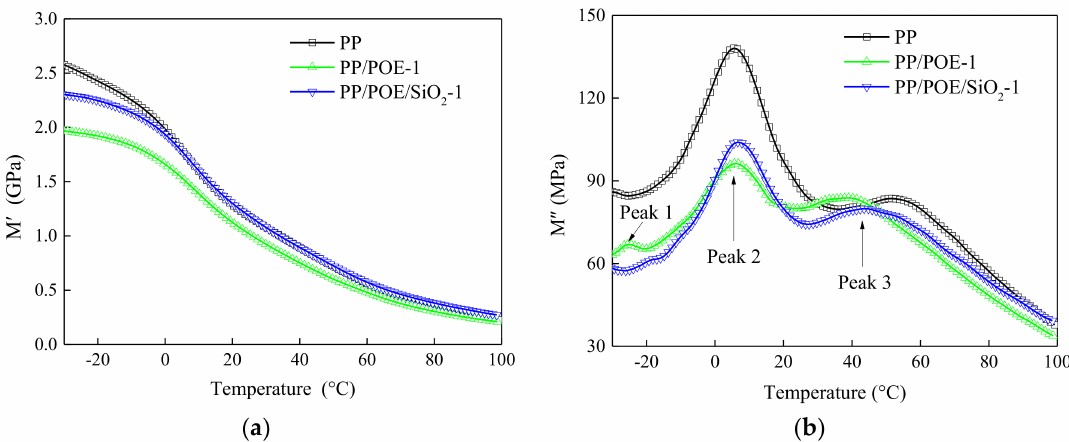
Figure 7. Storage modulus and loss modulus of PP and composites measured by dynamic mechanical analysis (DMA). ( a ) The storage modulus. ( b ) The loss